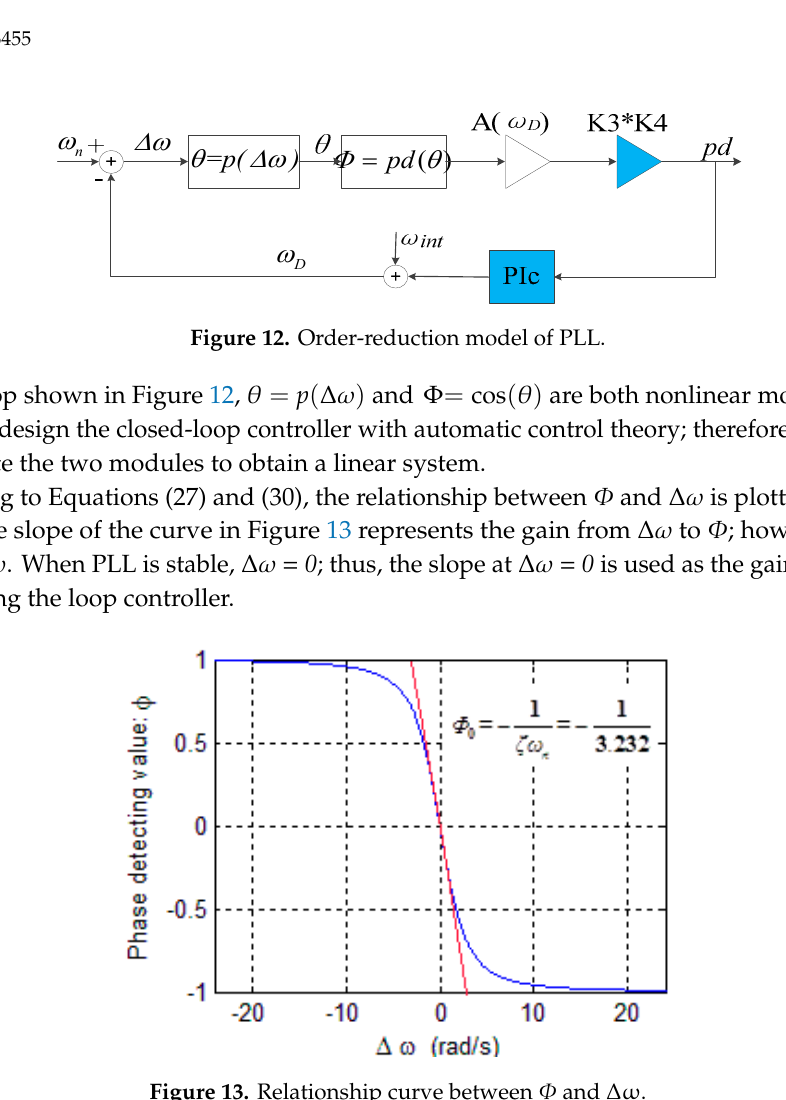
Figure 11. PLL loop after using equivalent gain method.